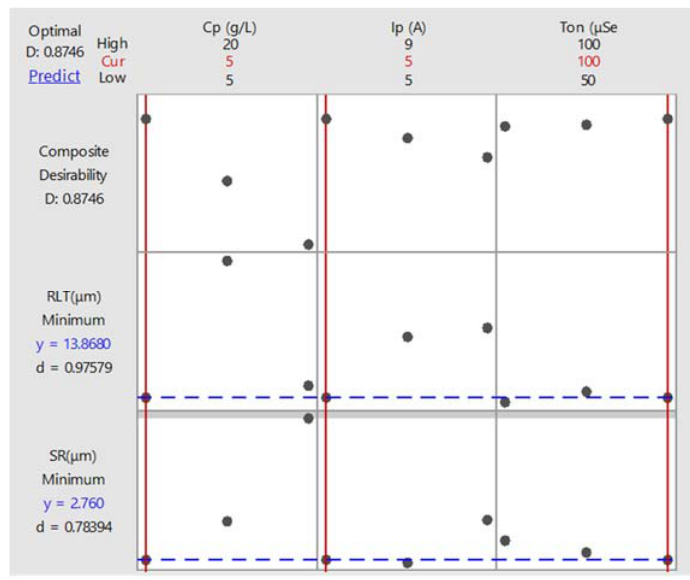
Figure 10. Parametric optimization for minimizing SR and RLT. Table 8. Optimized parameters.